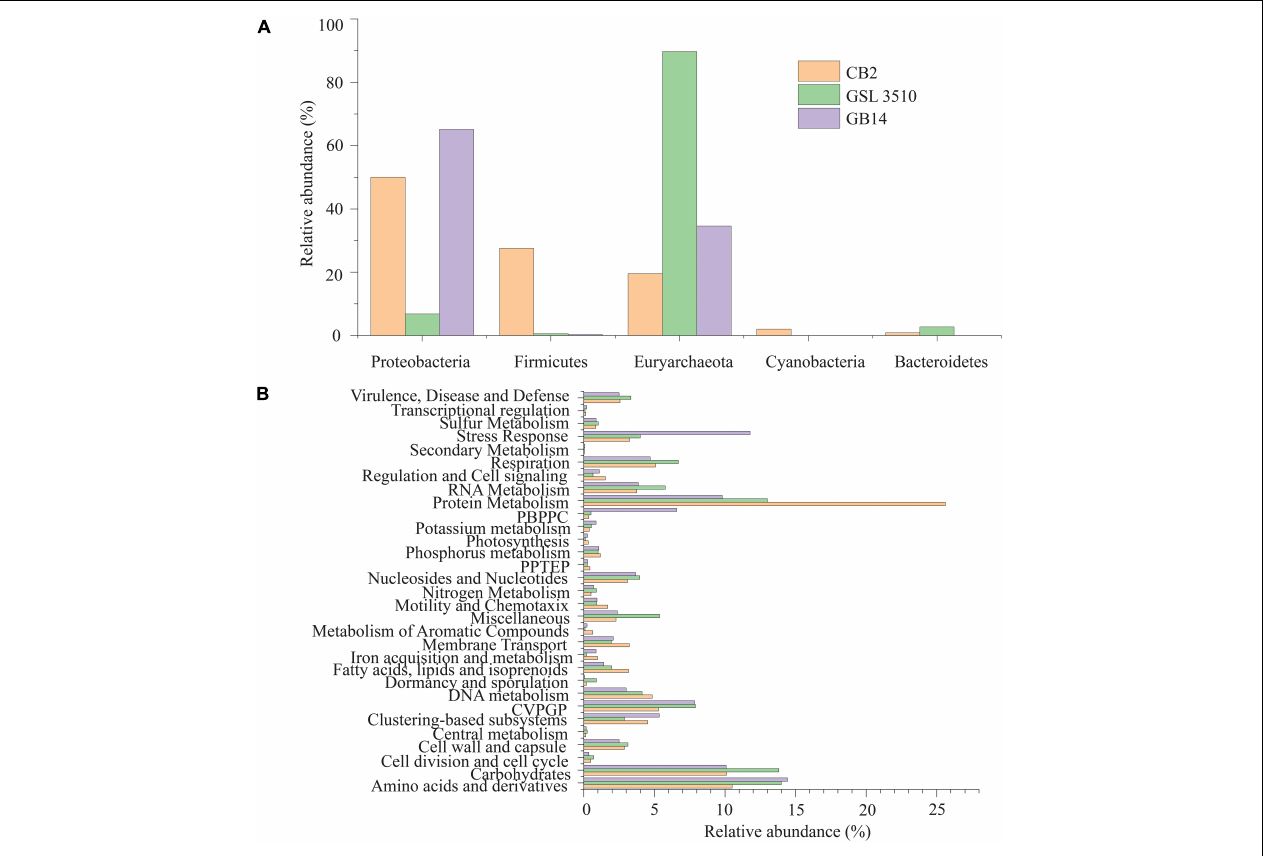
FIGURE 3 | (A) Phylum level classification of the bacterial and archaeal community across the Great Salt Lake sediments. (B) Functional classification (SEED subsystem Level I) of the bacterial and archaeal open reading frames (ORFs). (PPTEP, phages, prophages, transposable elements, plasmids; CVPGP, cofactors, vitamins, prosthetic groups, pigments; PBPPC, predictions based on plant-prokaryote comparative analysis).